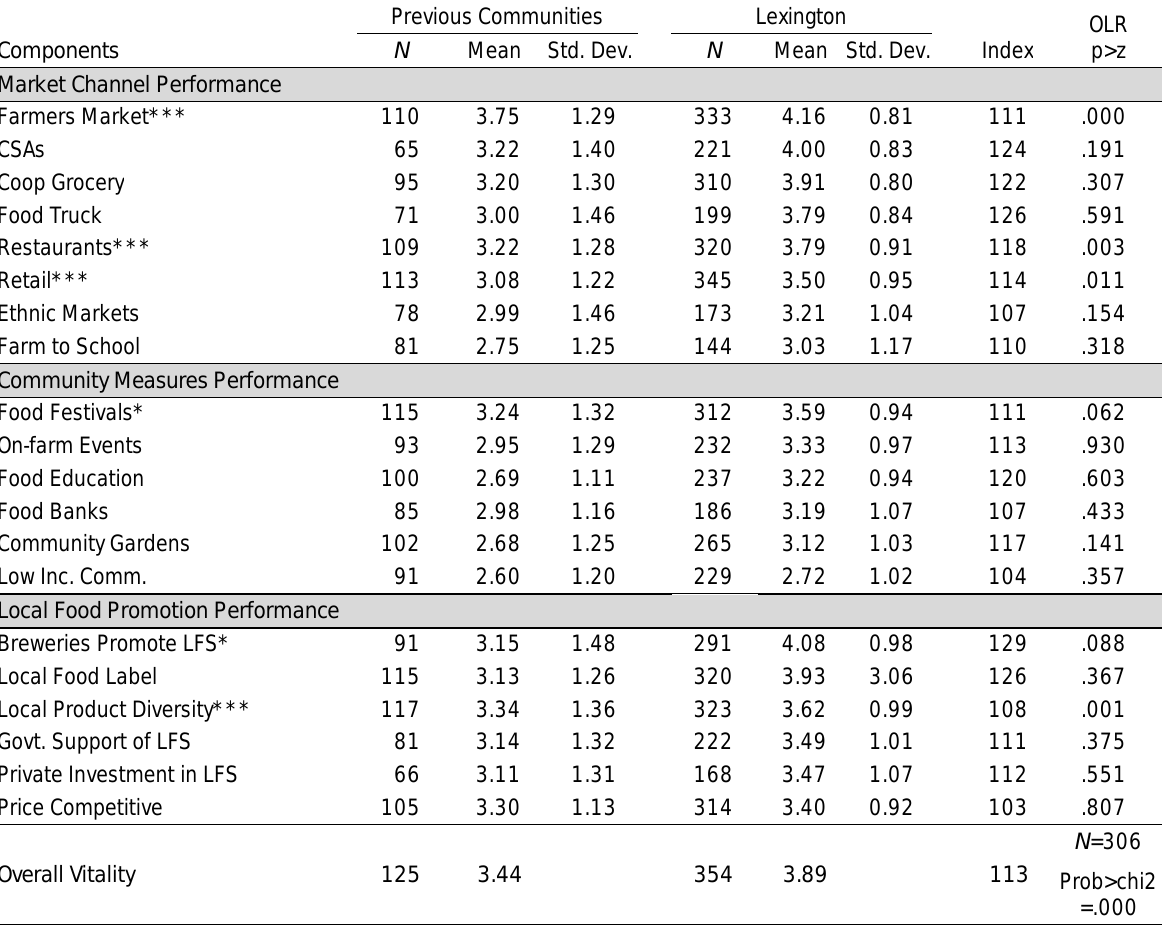
Table 1. Lexington Resident Perceptions of Local Food Systems (LFS) Component Performance